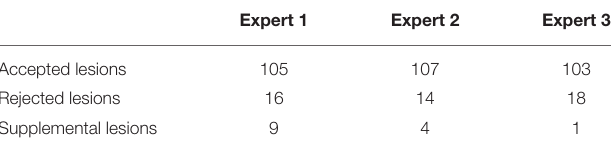
TABLE 4 | Relevance of the segmentation masks produced by the segmentation module.